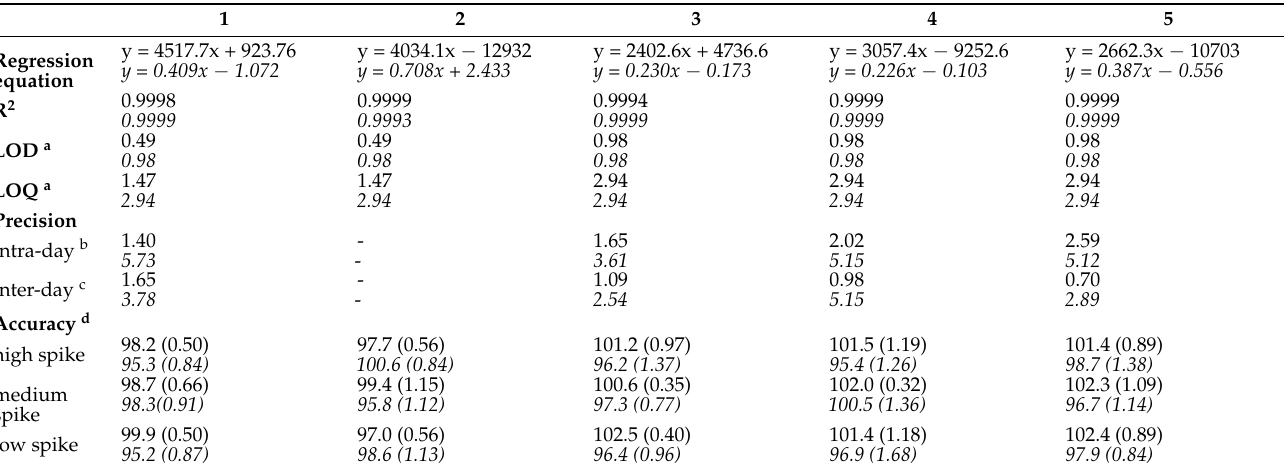
Table 1. Validation results of both techniques: SFC in plain text, CE in